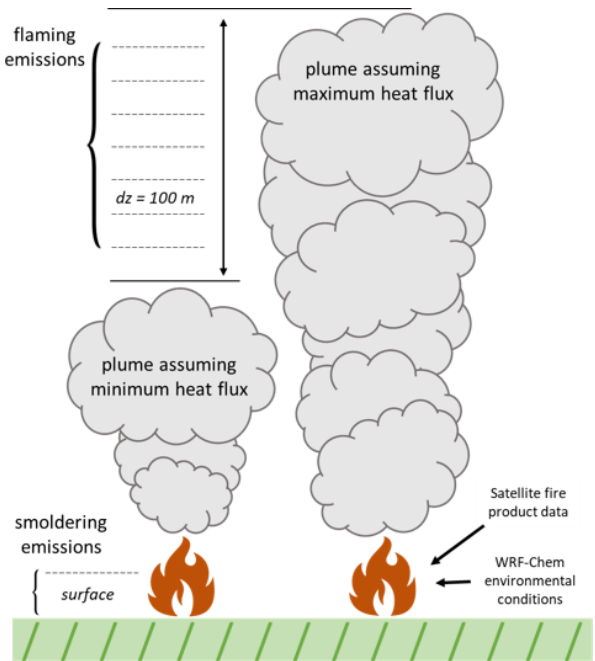
Figure 2. Plume rise model schematic. For each grid cell in which wildfire occurs, the plume rise model uses satellite fire products and the surrounding WRF-Chem environmental conditions to calculate two plume-top heights by using the land-type-dependent minimum and maximum wildfire heat fluxes. Smoldering-phase emissions are allotted to the surface layer, while flaming-phase emissions are dis- tributed linearly aloft within the injection layers at a vertical resolu- tion of